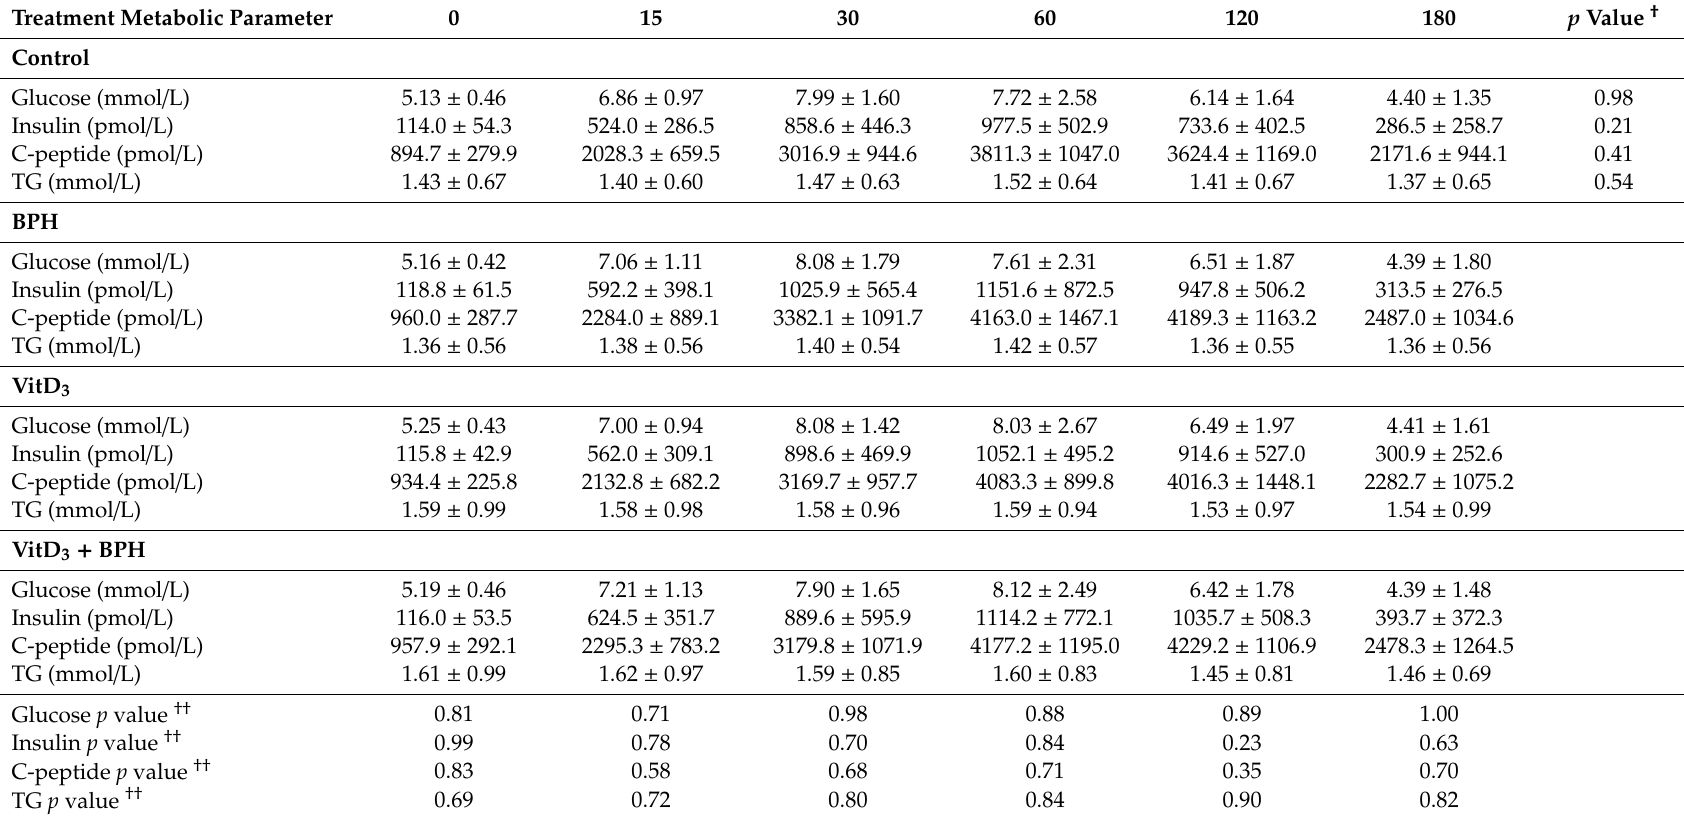
Table 2. E ff ects of treatments on glucose, insulin, C-peptide and triglyceride during oral glucose tolerance